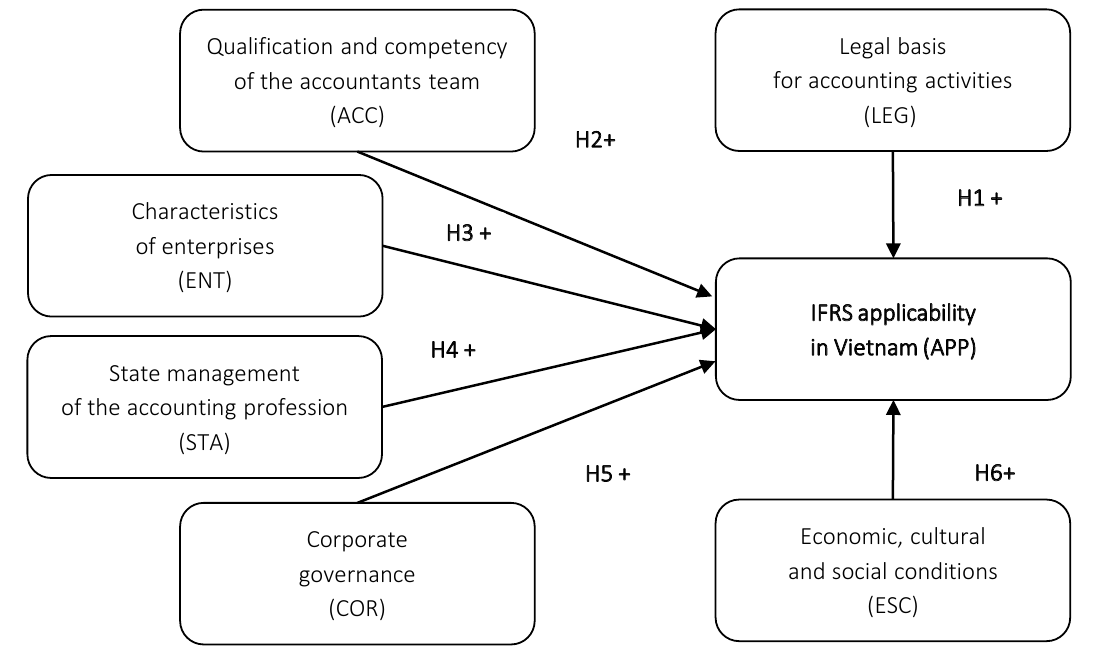
Figure 1. Research